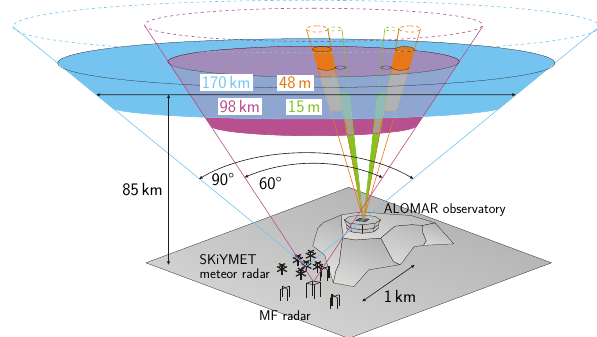
Fig. 1. Sounding volumes of RMR lidar (green), Na lidar (orange), meteor radar (blue), and MF radar (purple). The filled parts of the cones indicate the actual sounding volumes. The colored numbers indicate diameters of the corresponding sounding volumes at 85km